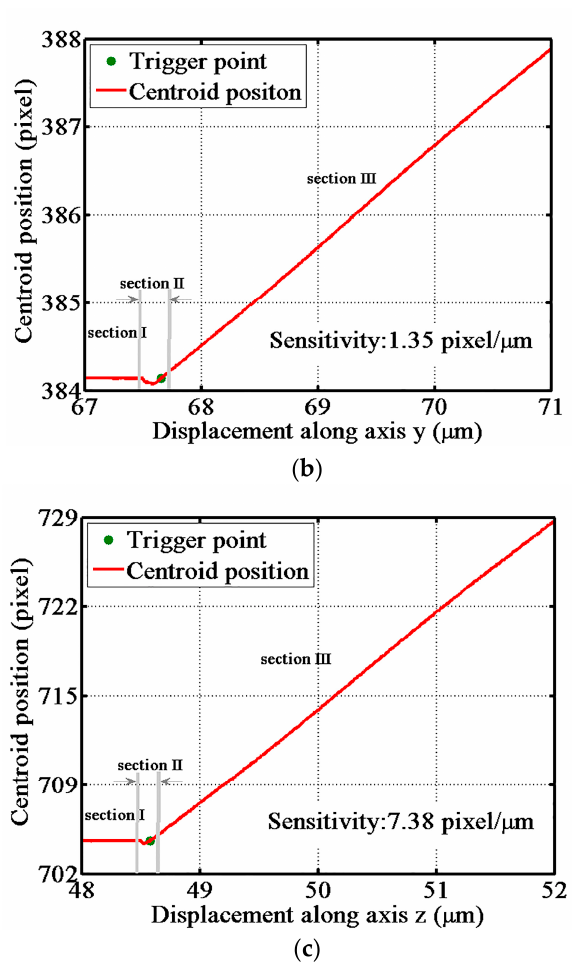
Figure 8. Output response curves of the probe: ( a ) Gauge block moves along the x-axis; ( b ) Gauge block moves along the y-axis; and ( c ) Gauge block moves along the z-axis.